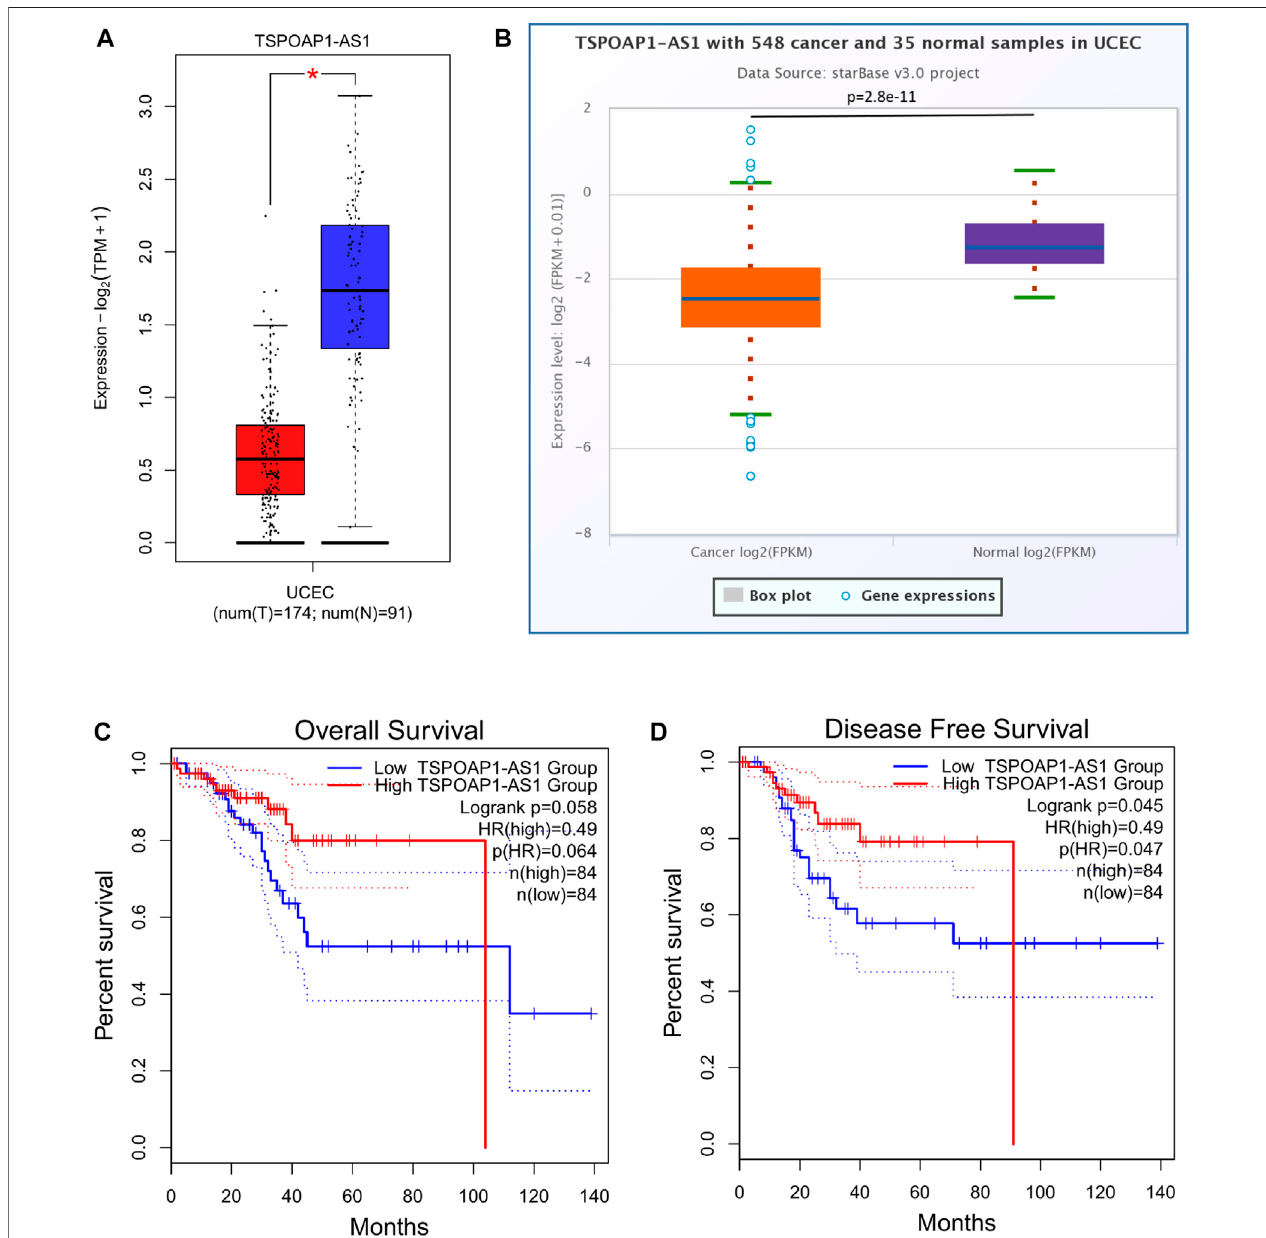
FIGURE 11 | TSPOAP1-AS1 is downregulated in UCEC, while its high expression predicts favorable outcomes. Expression analysis of TSPOAP1-AS1 using GEPIA2 (A) and StarBase (B) . * indicates p < 0.05. Survival analysis of TSPOAP1-AS1 in terms of overall survival (C) and disease-free survival (D) of UCEC patients.